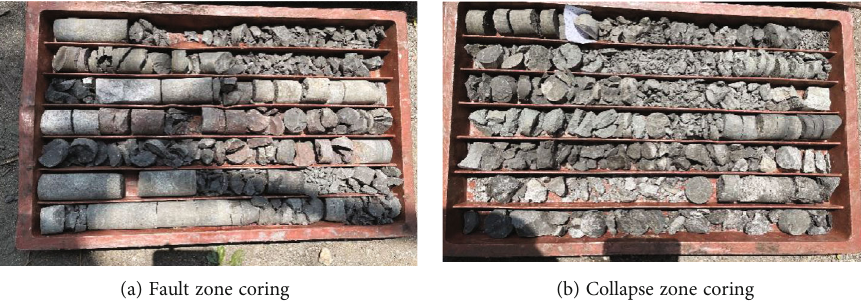
Figure 12: Diagram of drilling and coring. Table 6: Grouting design parameters of the example.